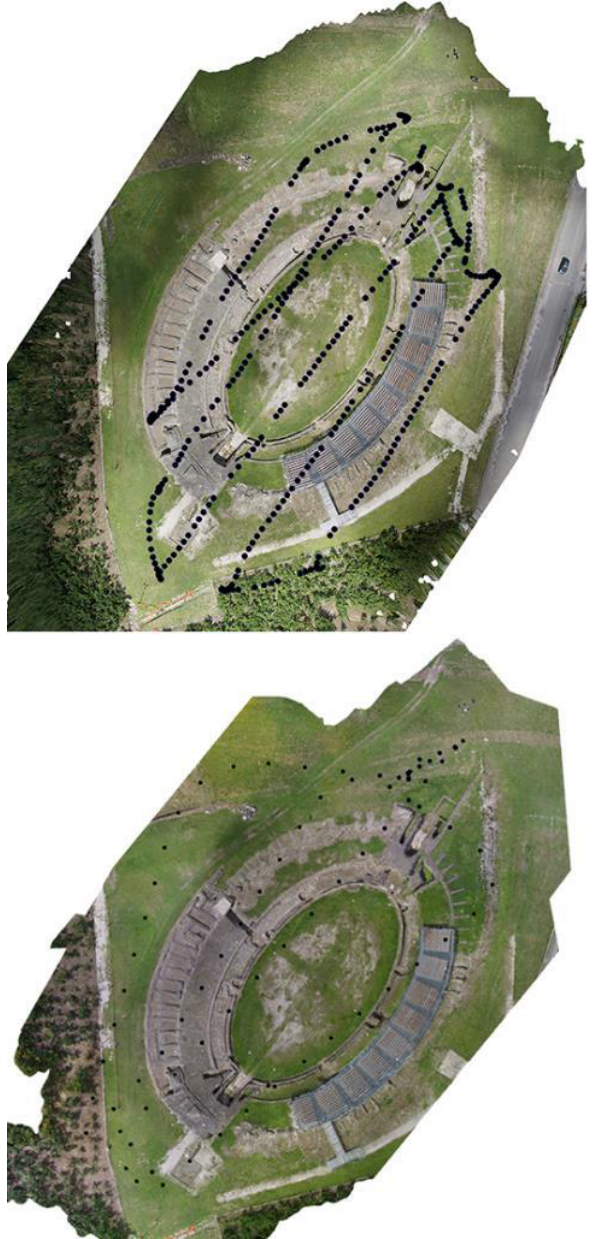
Figure 3: Nadir flight camera positions. Upper